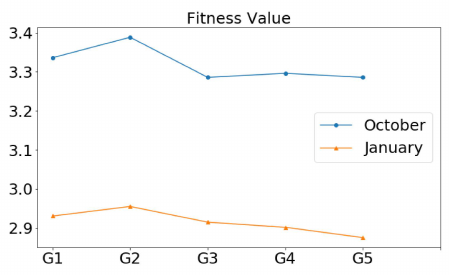
Figure 16. The fitness value of the simulation